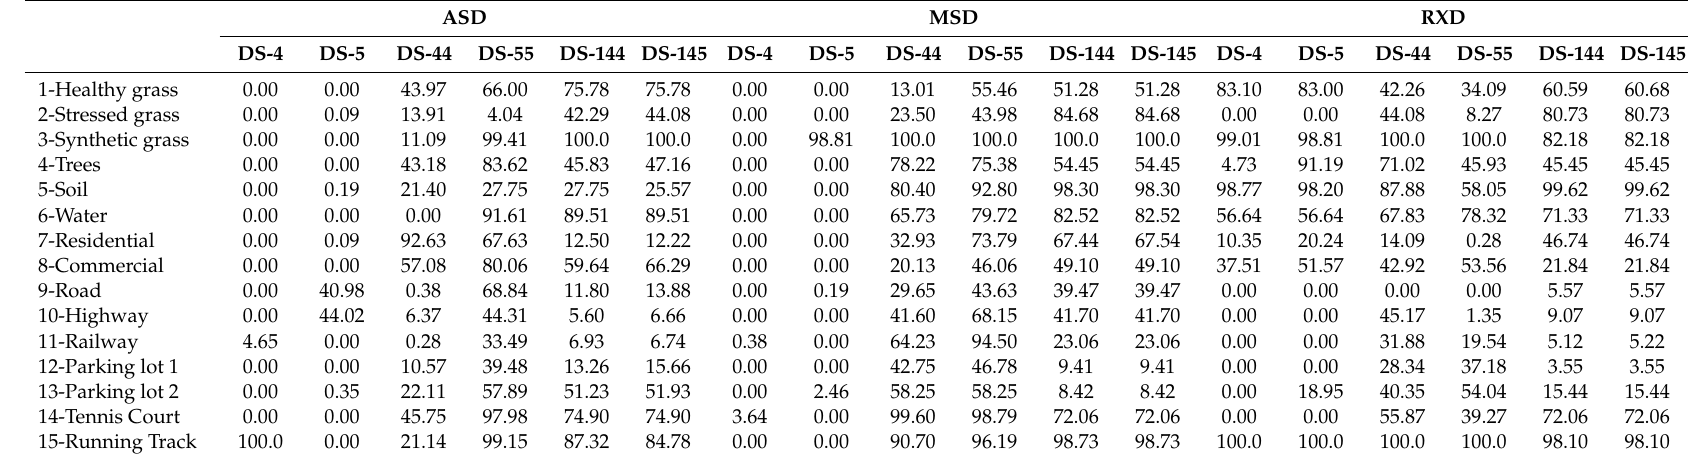
Table 6. Class specific accuracies of Adaptive Subspace Detection (ASD), Matched Signature Detection (MSD), and Reed-Xiaoli Detection (RXD) with various band combinations.